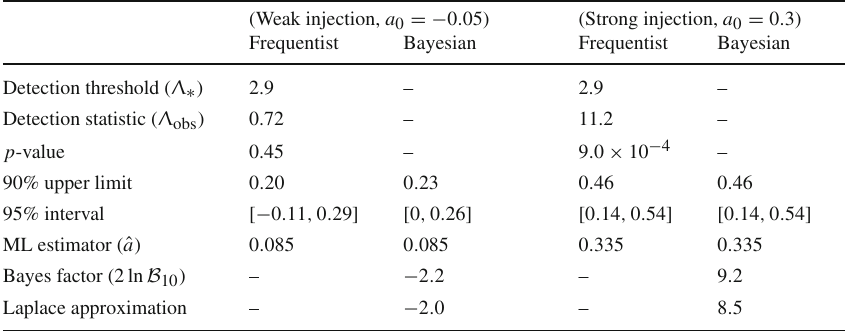
Table 4 Tabular summary of the frequentist and Bayesian analysis results for the simulated data (both weak and strong injections) (Weak injection, a 0 = − 0 . 05) (Strong injection, a 0 = 0 . 3) Frequentist Bayesian Frequentist